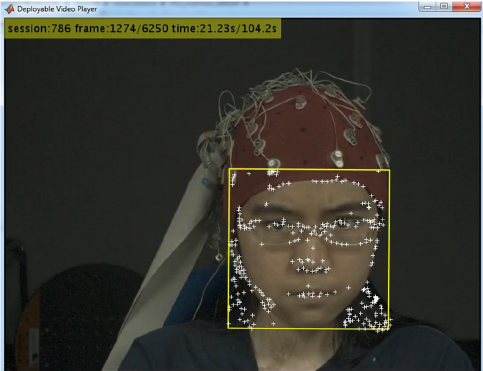
Figure 1. Example of face detection in Mahnob-HCI showing the feature points tracked along the video.